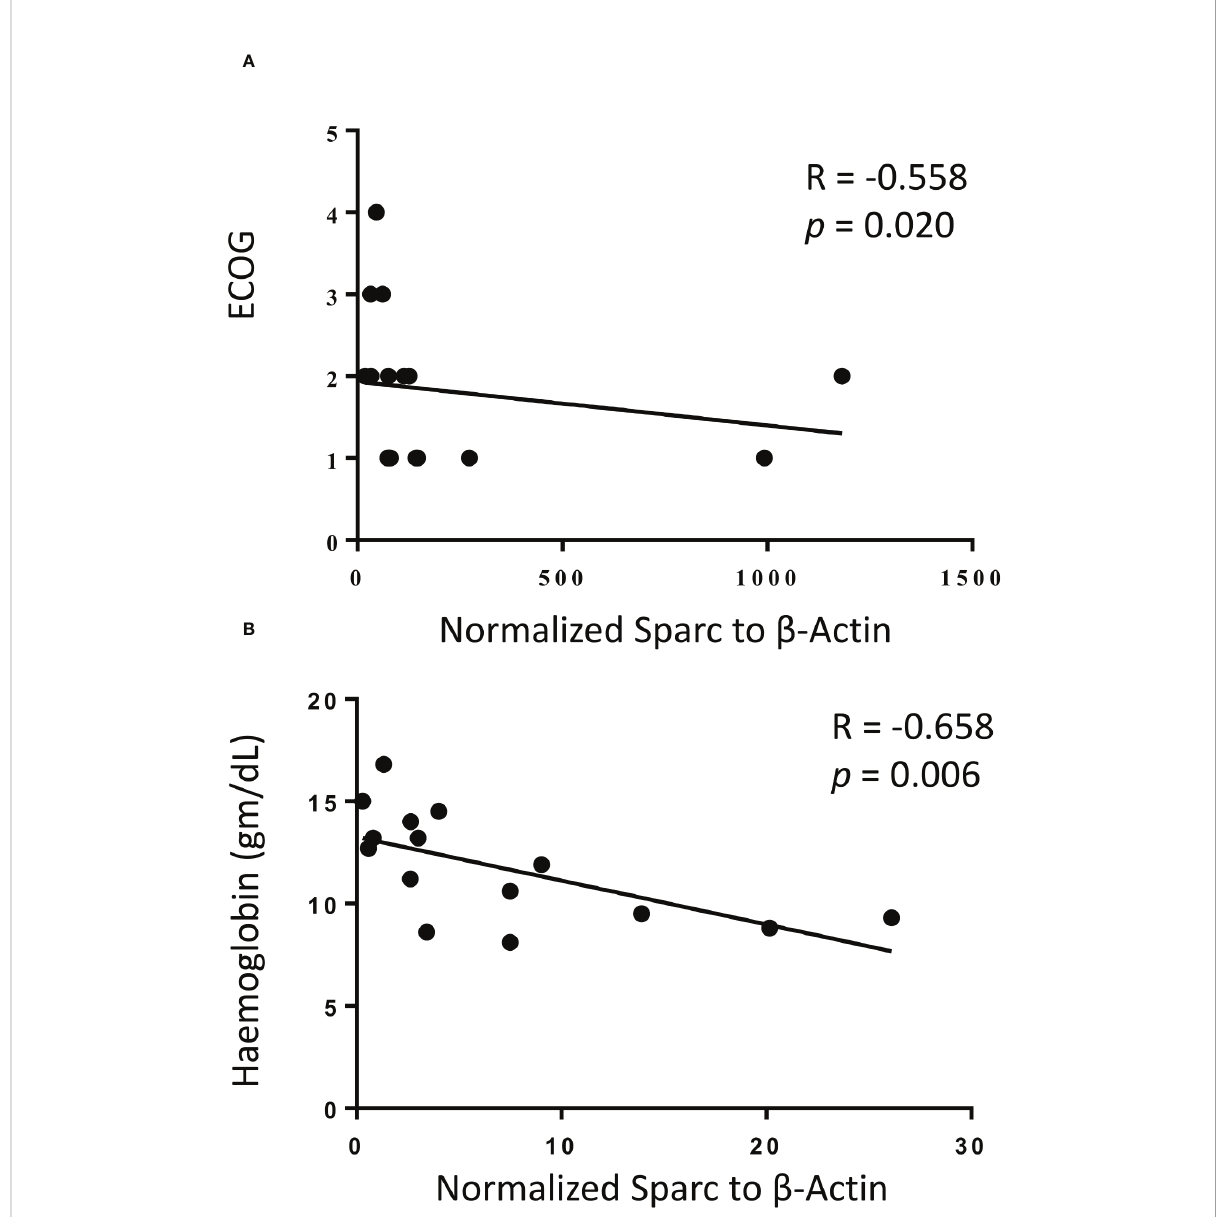
FIGURE 6 Correlation of bone marrow Sparc protein expression with ECOG performance status (A) and hemoglobin levels (B) following treatment in 14 matched multiple myeloma patients. Linear regression is shown as solid line, R = Spearman correlation, and p < 0.05 is considered signi fi